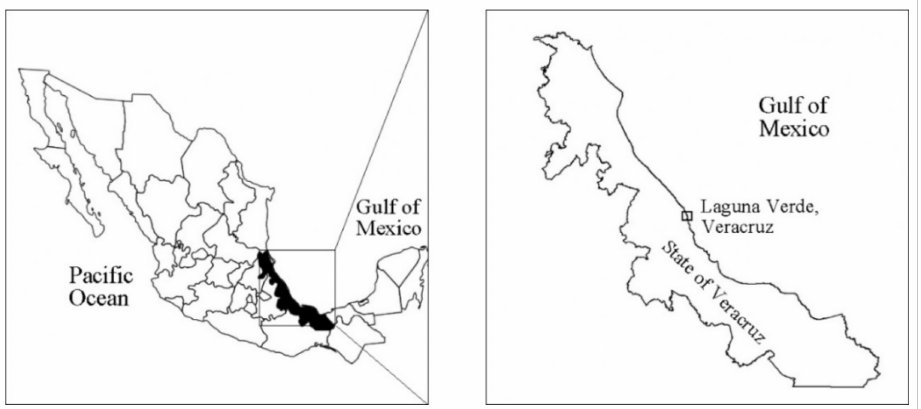
Figure 1. Location of the Laguna Verde nuclear power plant,